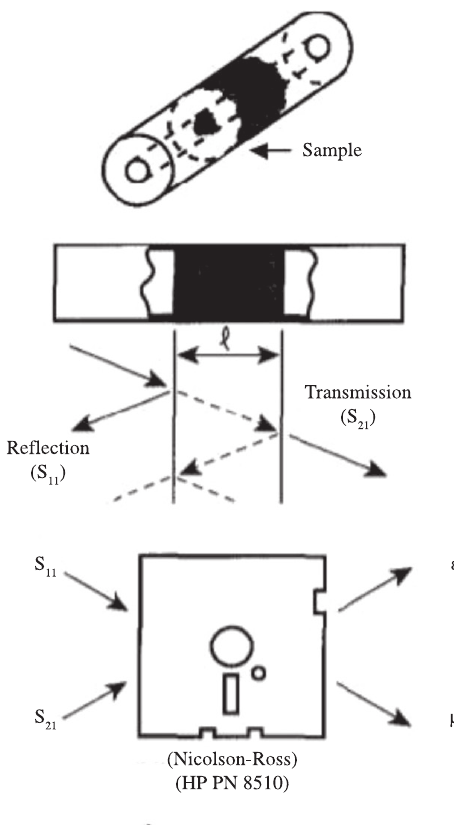
18 Figure 1. Representation of the transmission/reflection line 7 .